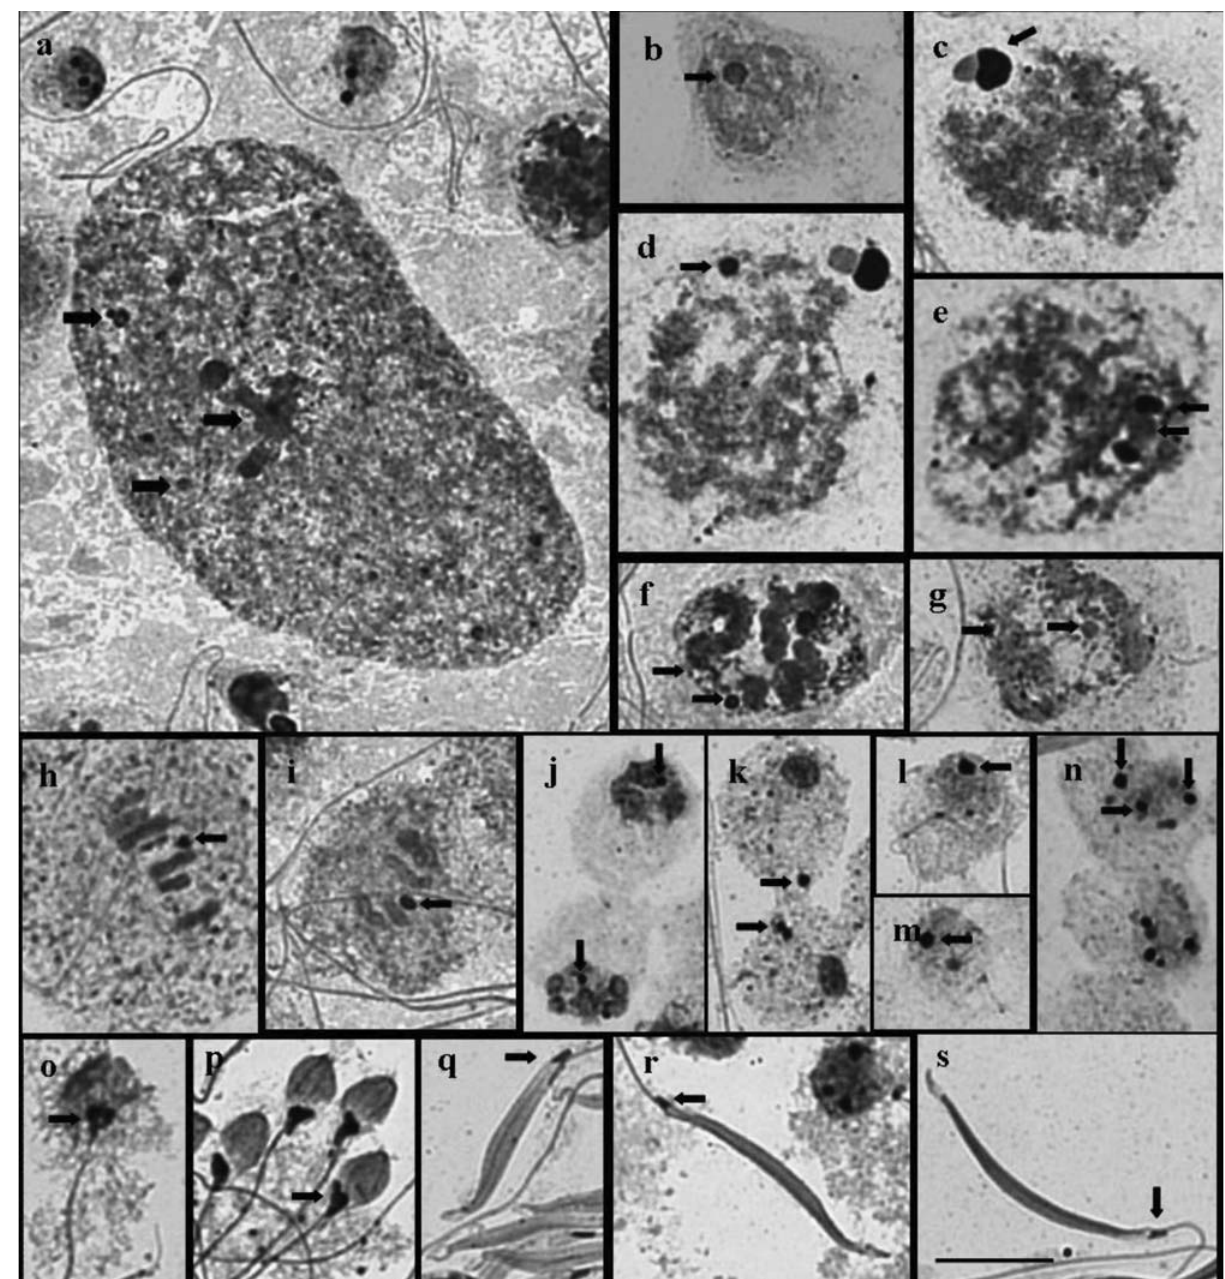
Figure 2 - Seminiferous tubule cells of Mormidea v-luteum (A, B, F, G, I and N), Oebalus poecilus (L, M, P and R) and Oebalus ypsilongriseus (C, D, E, H,J,K,O,QandS)adultmales,impregnatedbysilvernitrate. A) Polyploidnucleiofnutritivecellscontainingalargemassofnucleolarmaterialandsev- eral small corpuscles (arrows); B) One large nucleolar corpuscle is present in the cell nuclei at leptotene (arrow); C, D) In both Oebalus species two asso- ciated nucleolar bodies are present at zygotene, one more impregnated than the other and showing a mushroom-like shape (C, arrow); note a small addi- tional corpuscle in D (arrow); E-G) Beginning of the disorganization process of the nucleolar material at pachytene/diplotene (arrows); H, I) metaphases Iinlateralviewwiththenucleolarmaterialstillpresent(arrows); J,K) nucleolarmaterialalsopresentattelophase(arrows); L-N) Roundspermatidswith a variable number of nucleolar bodies (arrows); O-S) Spermatids with different degrees of elongation; the nucleolar material is located in the posterior re- gion of the head (arrows). Bar = 10 μ